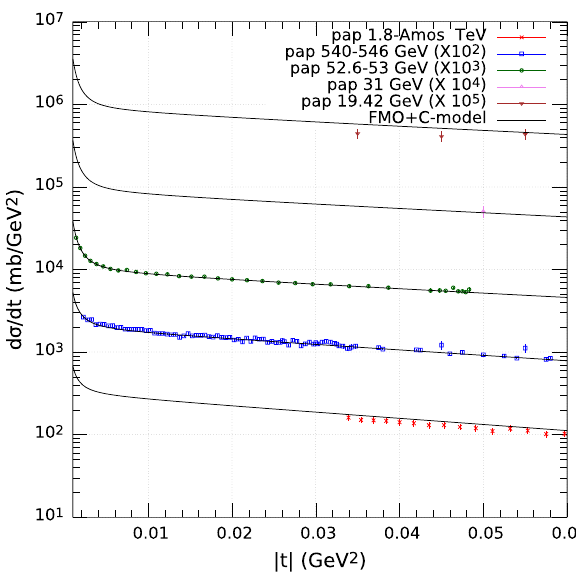
Fig. 4 pp differential cross sections at